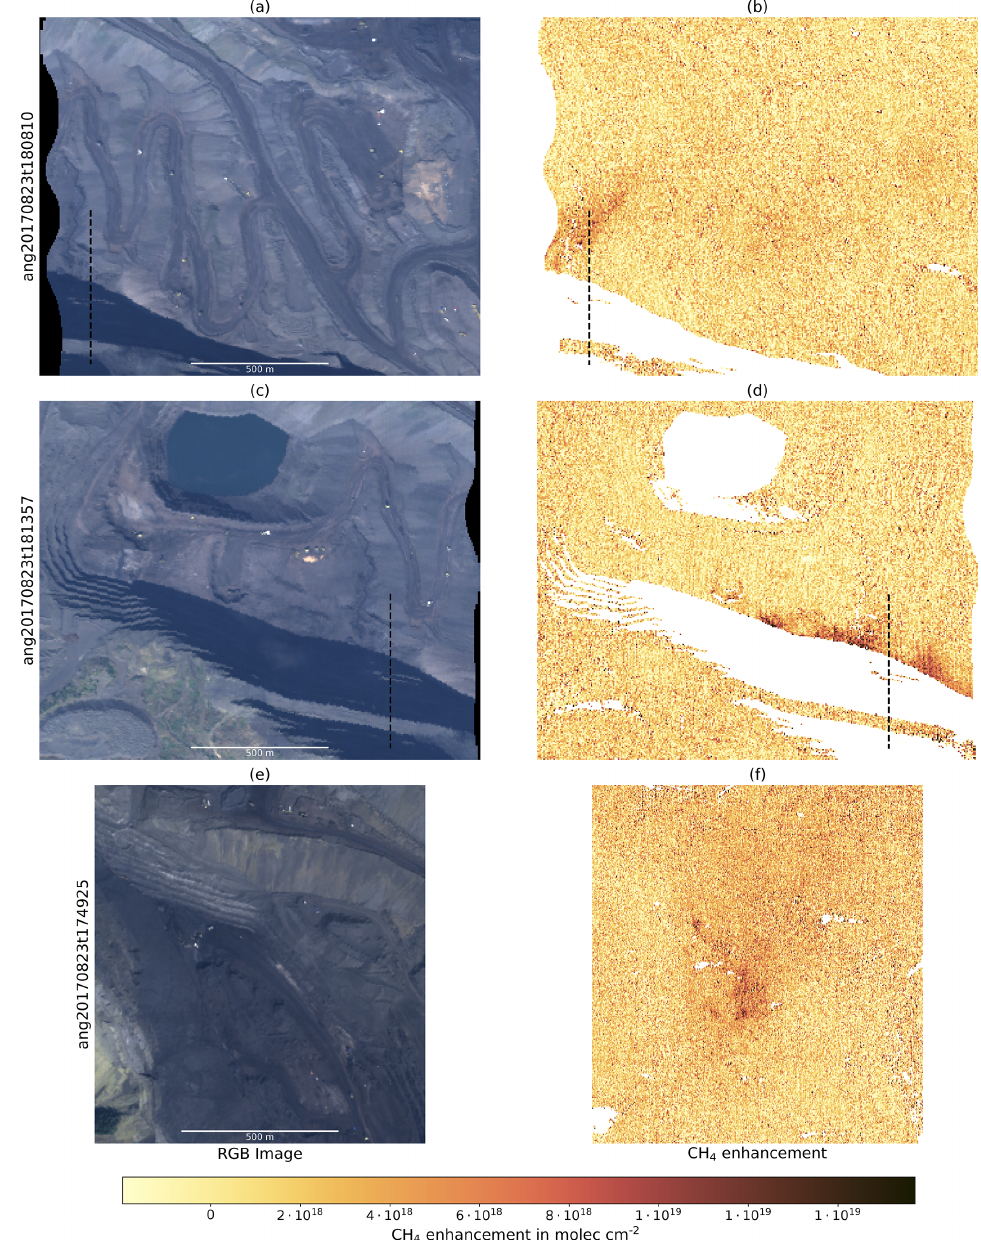
Figure C1. Same as Fig. 9 but for methane enhancements after application of the proxy resulting from bituminous coal extraction. The upper two measurements were taken within ∼ 10min and show the same brim. The dashed line is plotted on the same location in both images. While in panel (b) a plume emanating from the brim is visible, in panel (d) strong accumulations near the brim are visible. In panel (f) , the plume is more diffuse, and the highest enhancements are visible near a brim. However, it is not as clear as in panels (b) and (d) if it really originates from the brim or might be an